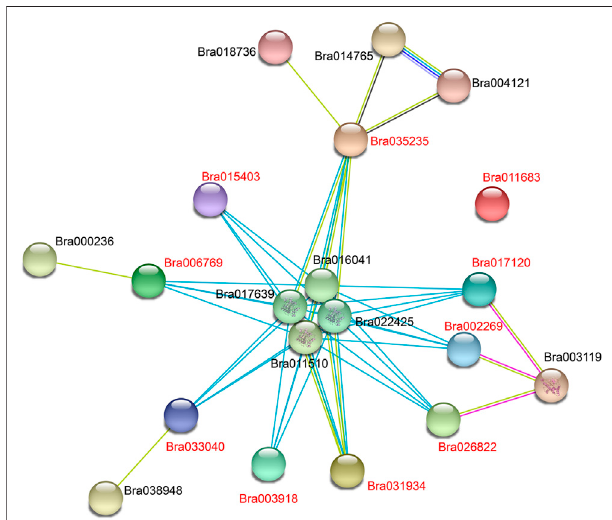
FIGURE 9 | Predicting interactions between BrAPXs using STRING software (Szklarczyk et al., 2021). The 10 BrAPX proteins screened are labelled in red. Network nodes represent proteins, and edges represent protein-protein associations. Light blue lines represent known interactions from curated databases, pink lines represent known interactions determined experimentally, blue lines represent gene co-occurrence, yellow lines represent text mining, and black lines represent